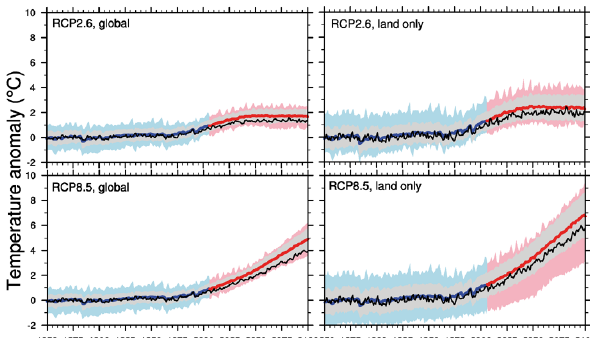
Fig. 7. Model calculated annual surface air temperature anomalies relative to the 1850–1899 average for RCP2.6 (upper panels) and RCP8.5 (lower panels), averaged globally (left panels) and over land areas (right panels). Black lines: NorESM1-M; blue and red lines: ensemble mean over 15 other models contributing to CMIP5, grey shading: one standard deviation on each side of the ensemble mean; blue and red shading: range defined by max and min values amongst the 15